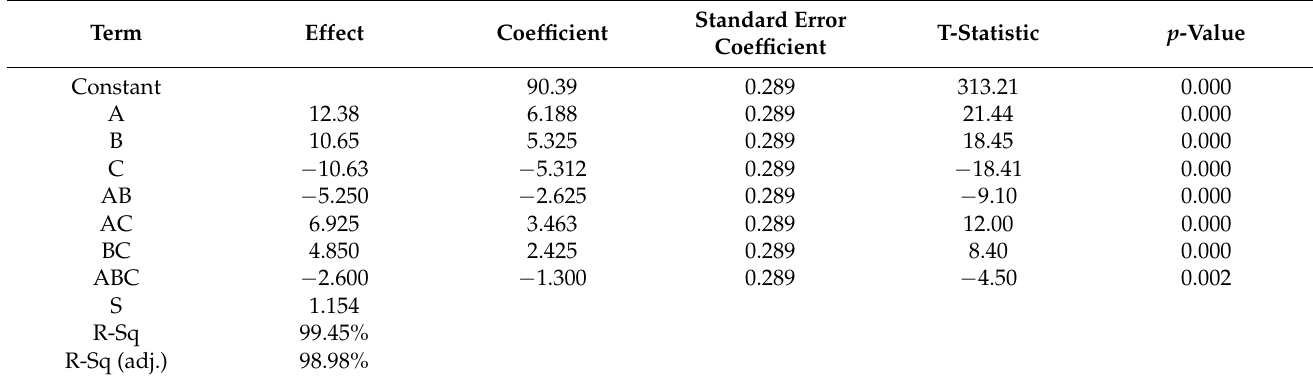
Table 4. Estimated regression coefficients of the factors and their effects on MO